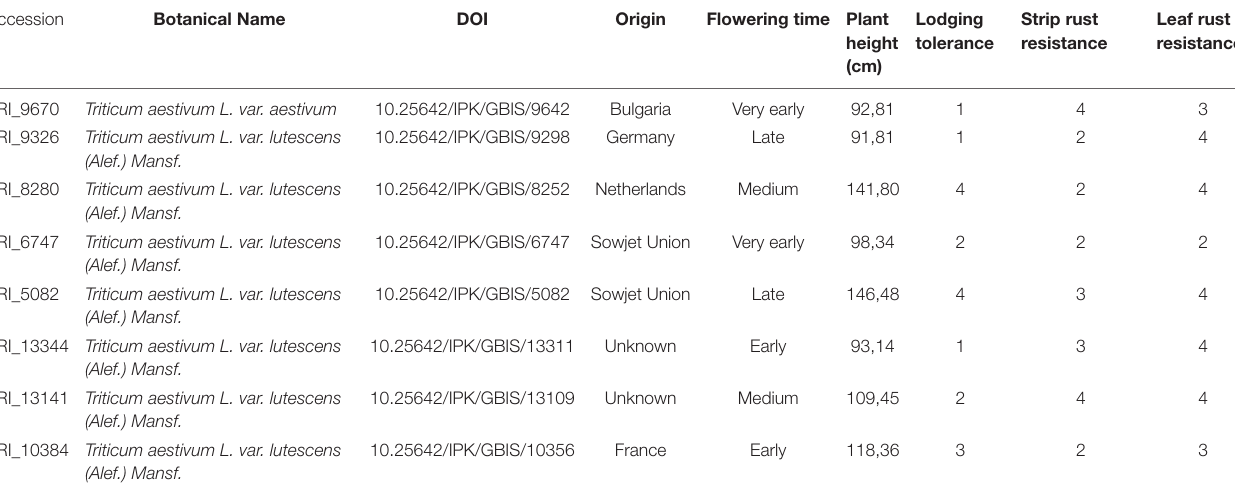
TABLE 1 | Description of plant genetic resources used as male parents in hybrid seed production